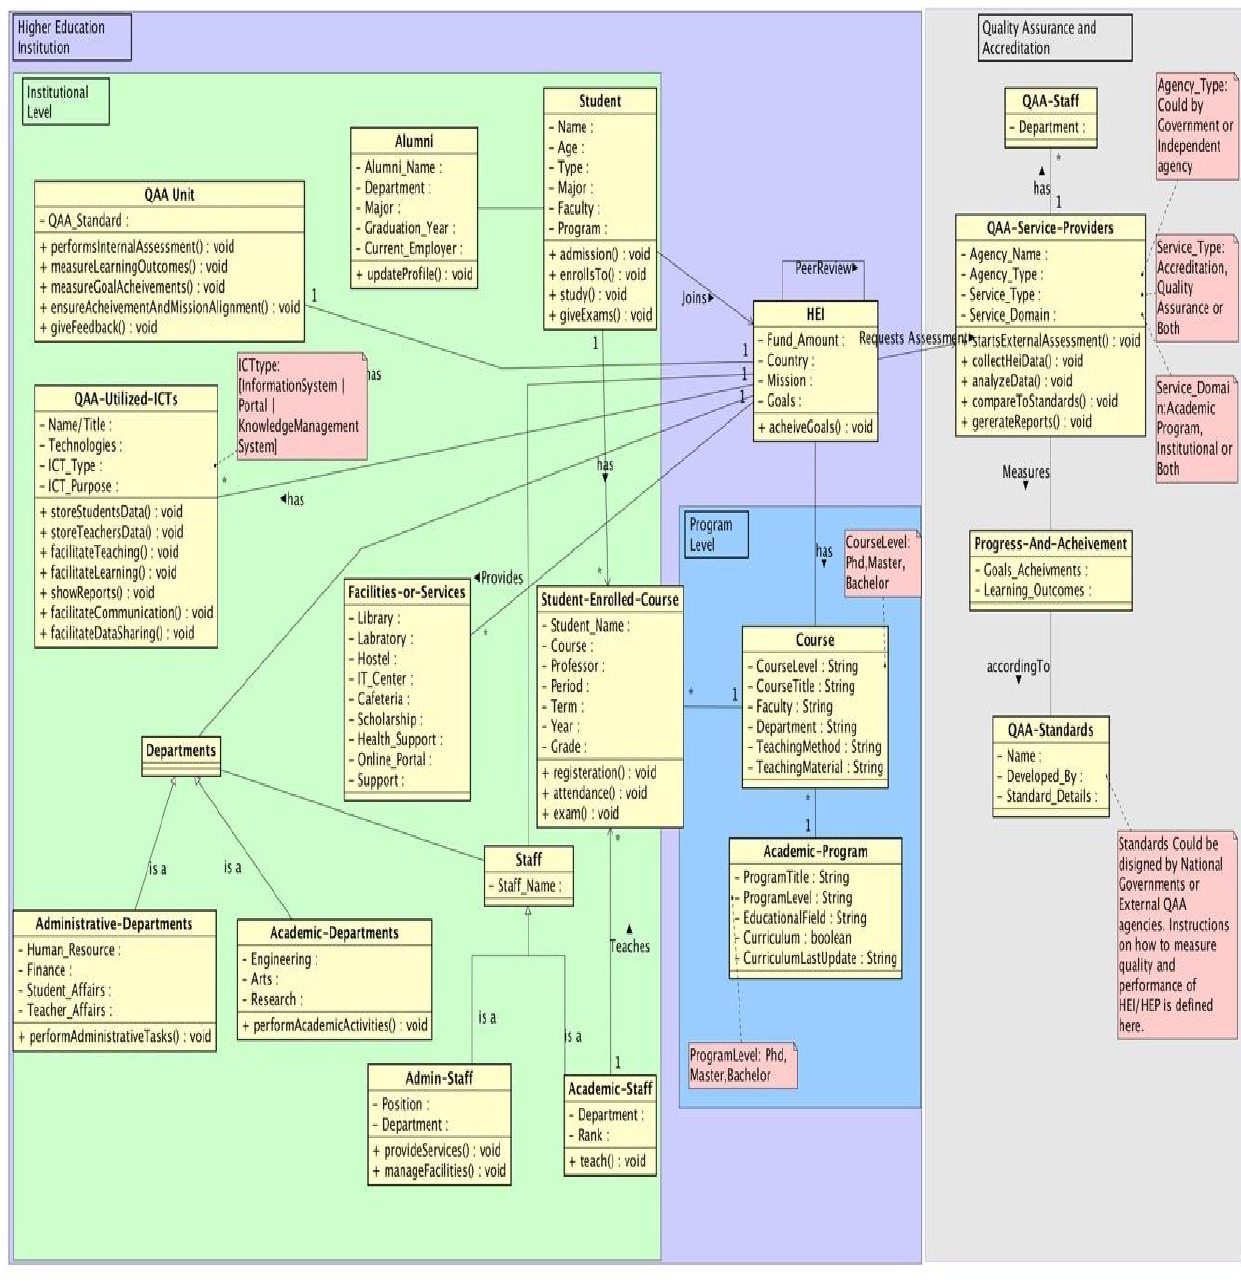
Figure 3 . Conceptual model of QAA